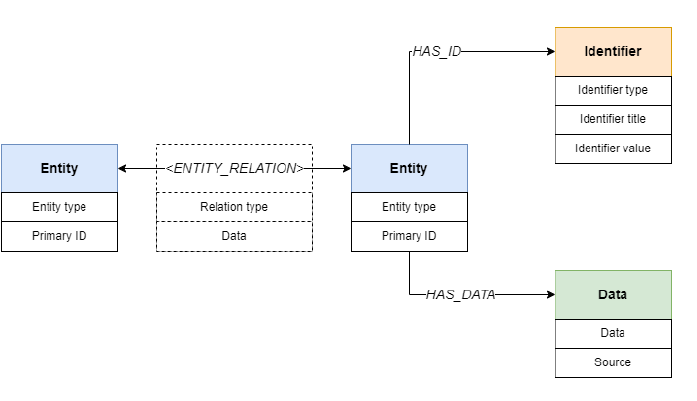
Figure 1. Base schema of the BioGraph model. Entities of specified types, identified using primary identifiers, have connections with all of their identifiers and data objects, as well as with other entities. The identifier objects contain information about the nature of the identifier and the identifier values, while data objects store metadata collected from datasets along with the label of the dataset source. Relations between entities are defined using the relation type and additional data that can further explain the nature and strength of the